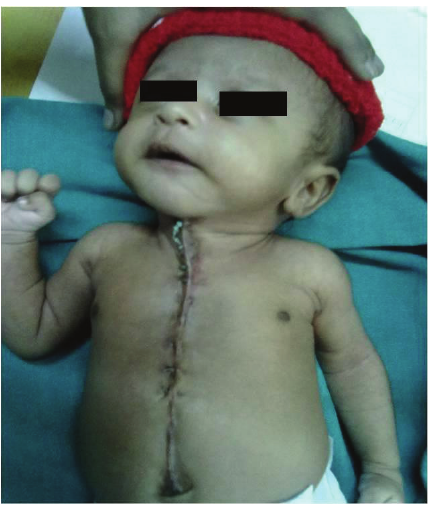
Figure 3: Postoperative